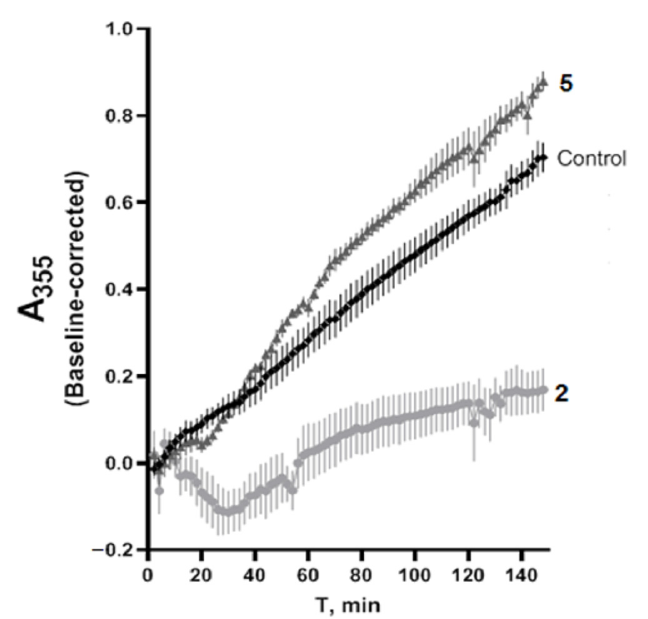
Figure 8. The influence of compounds 2 and 5 (100 μ M) on Tb+MAP polymerization. Results presented as mean ± SD obtained using at least from three independent experiments.